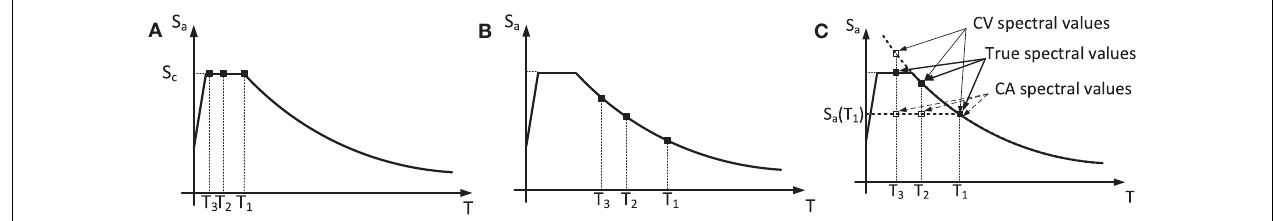
FIGURE 3 | Location of the first natural periods in the response spectrum: (A) all in the CA region, (B) all in the CV region, and (C) some in the CV region while others in the CA region .